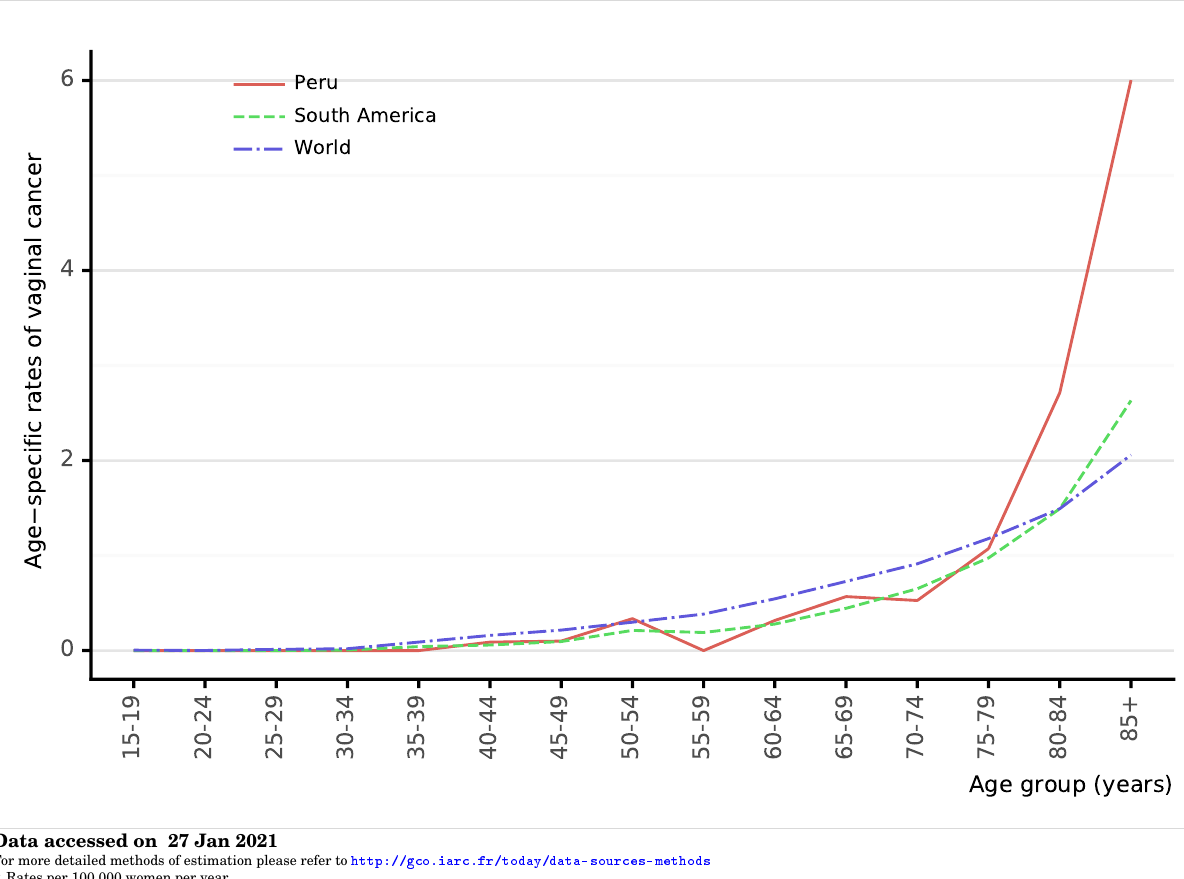
Figure 118: Comparison of age-specific vaginal cancer mortality rates in Peru, within the region, and the rest of